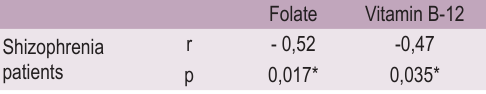
TABLE 3. Correlation between homocysteine and vitamins in patients with shizophrenia.